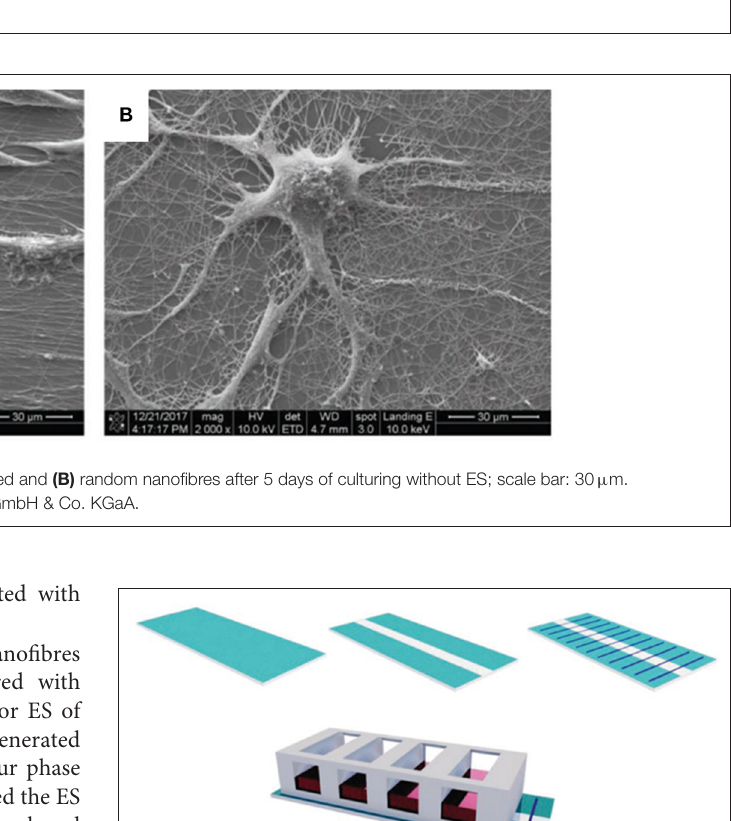
FIGURE 8 | Electrical stimulation device setup with ITO substrate; ITO substrate with an etching gap; aligned nanofibers electrospun on the modified ITO substrate; aligned nanofibers electrospun on the modified ITO substrate inside a chamber slide. Reproduced from (86) with permission from Wiley-VCH Verlag GmbH & Co.